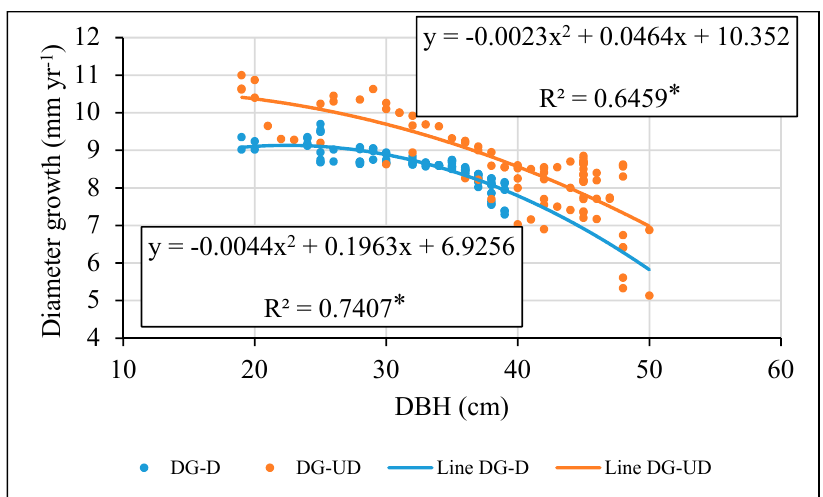
Figure 8. Diameter growth of undamaged (DG-U) and damaged (DG-D) trees in relation to tree dbh.